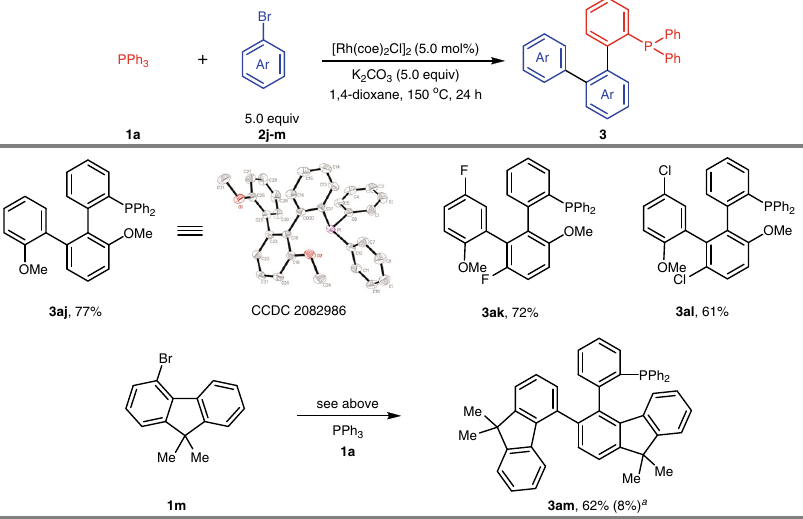
Fig. 3 Substrate scope of two-fold direct arylation. Reaction conditions:[Rh(coe) 2 Cl] 2 (5.0 mol %), 1a (0.2 mmol), 2j – m (1.0 mmol), K 2 CO 3 (1.0 mmol) in 1,4-dioxane (0.5 mL) at 150 °C for 24 h under argon. a Yield of monoarylation